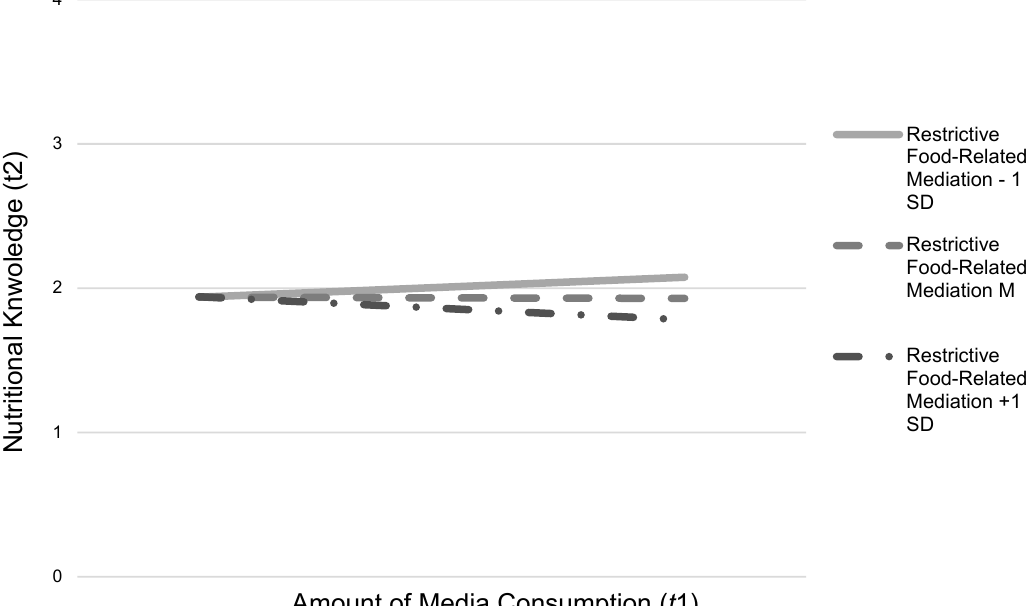
Figure 2. Interaction effects of children’s amount of media consumption ( t 1) and restrictive food-related mediation ( t 1) on children’s nutritional knowledge ( t 2).